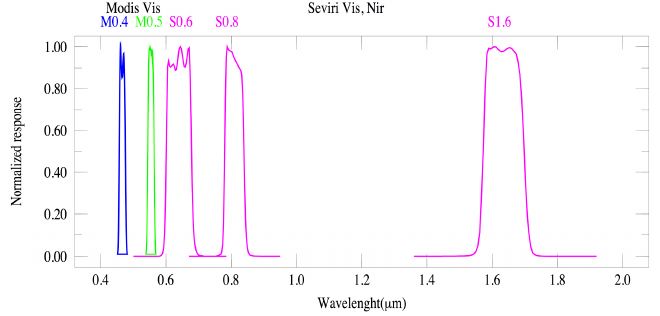
Figure 1. Spectral bands of SEVIRI. The data are acquired in real-time every 15 min from the EUMETSAT satellite and are processed by the EUMETSAT ground processing to deliver the LEVEL1 end products.